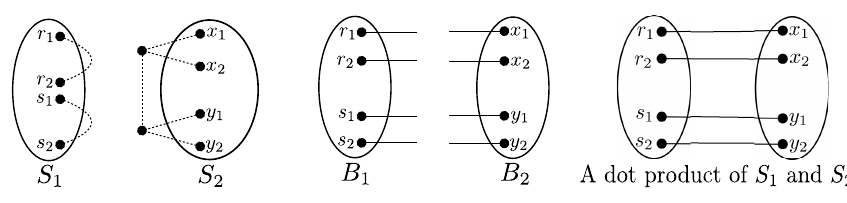
Fig. 1: An illustration of the dot product of S 1 and S 2